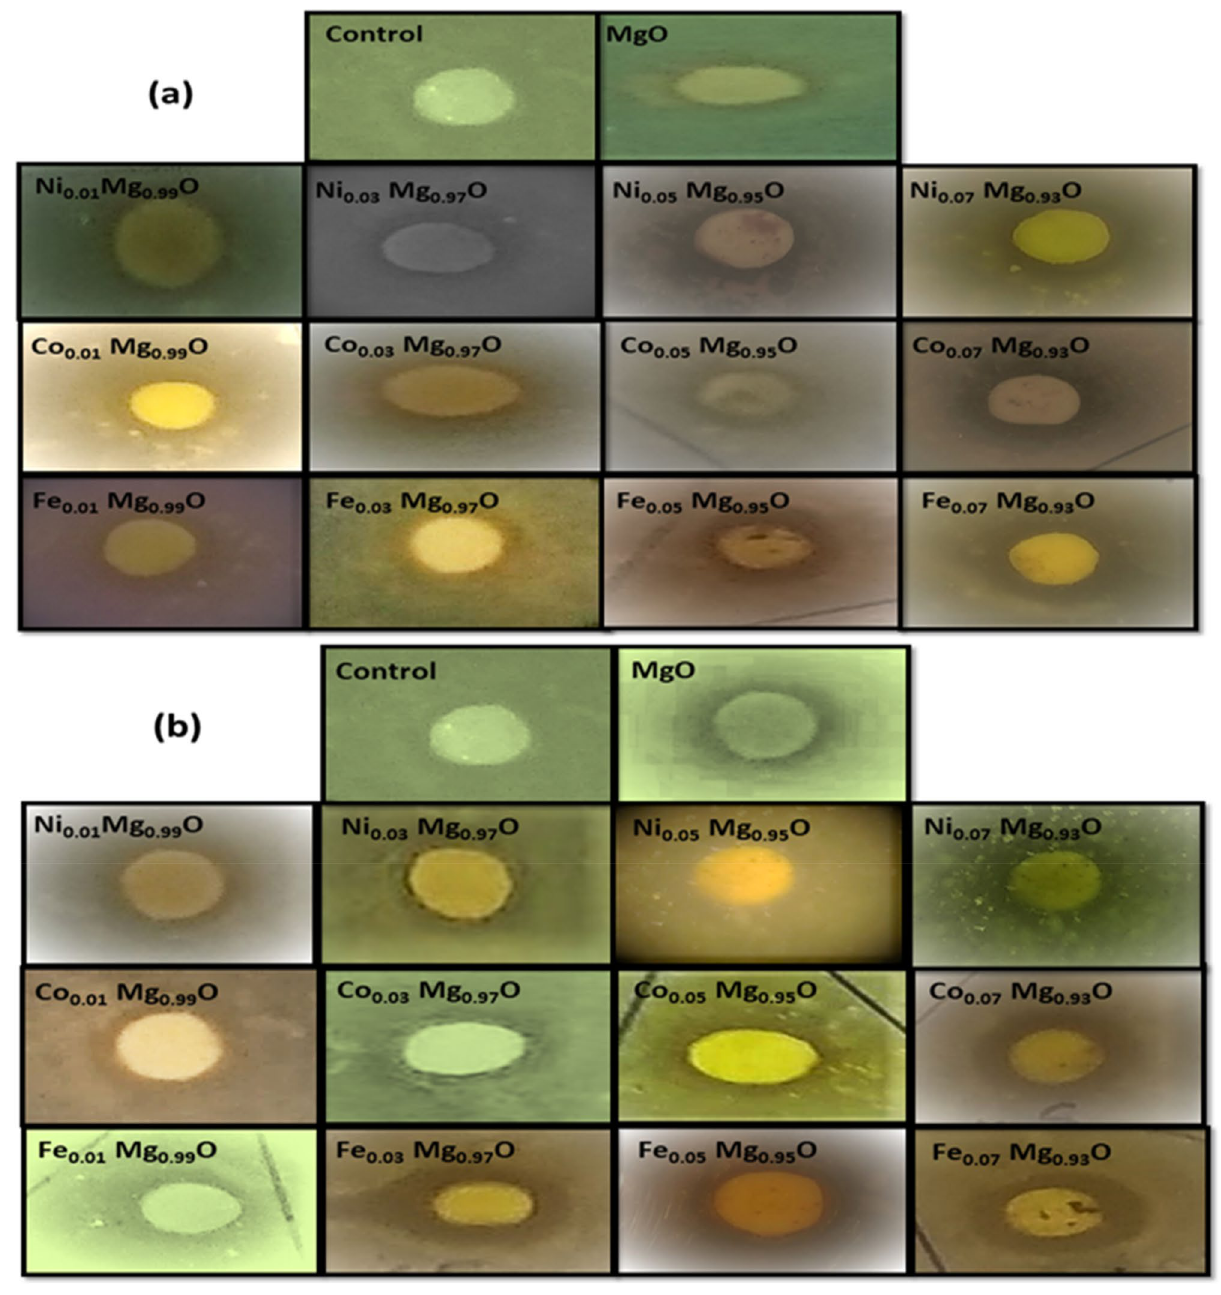
Figure 15. Appearances of the zone of inhibition for ( a ) 40 μg/ml of Ni, Co, and Fe-doped MgO nanoparticles. ( b ) 80 μg/ml of Ni, Co, and Fe-doped MgO nanoparticles with E.